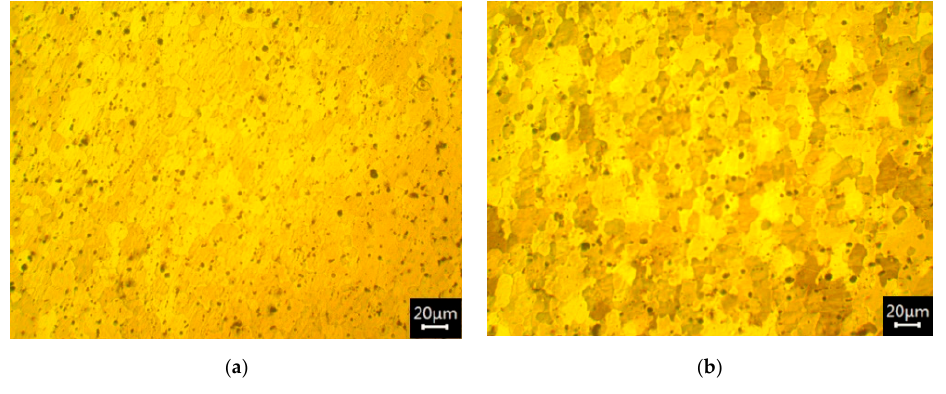
Figure 15. Deformed shape of AA5083 rod. ( a ) front view; ( b ) bottom view; ( c ) cross-section view.